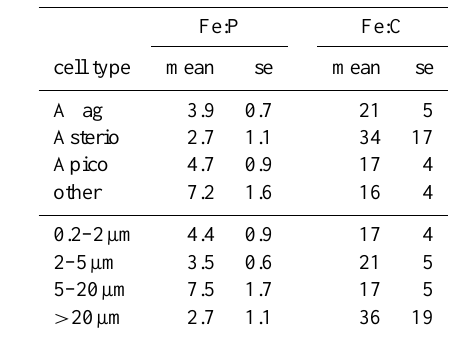
Table 5. Least-square means ( ± standard error; se) of Fe:P and Fe:C (C calculated using biovolume estimates) based on taxonomic class described in Table 4 and size